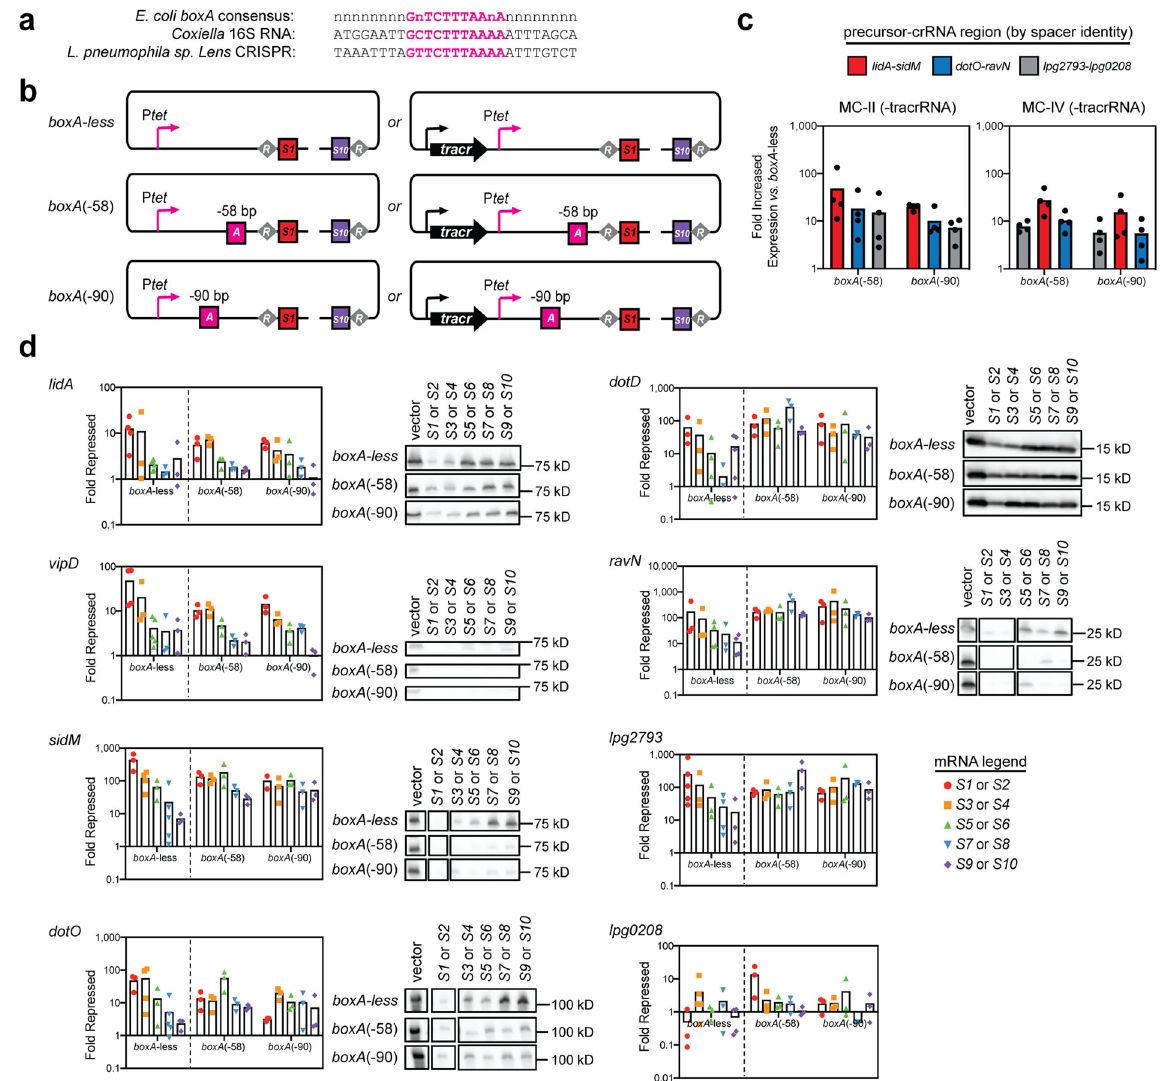
Fig. 4 The effect of boxA elements on gene silencing by P tet - MC arrays. a Sequence alignment of the boxA elements identi fi ed in E. coli (boxA consensus), Coxiella (16 S RNA encoding sequence), and L. pneumophila sp. Lens (CRISPR array). b The boxA motif from the L. pneumophila sp. Lens CRISPR array was added to the leader sequence of the P tet - MC constructs either -58 ( boxA (-58)) or -90 ( boxA (-90)) base pairs upstream of the repeat/spacer array. boxA is depicted as a pink square. c Constructs lacking the tracrRNA-encoding sequence were used to probe precursor-crRNA expression from boxA - containing vs. boxA -less constructs in axenic cultures of Lp02( dcas9 ) ( + 40 ng/mL aTC). Precursor-crRNA levels were measured by qPCR using primer pairs that annealed to three different regions of the precursor-crRNA. Fold increased expression vs. boxA -less constructs was determined using ΔΔ C T . Data are ordered by spacer position in constructs MC-II or MC-IV. d Constructs with the tracrRNA-encoding sequence were used to probe gene repression by qPCR of RNA from axenic cultures of Lp02( dcas9 ) bearing boxA constructs to that with the empty vector ( + 40 ng/mL aTC). Fold repression was determined using ΔΔ C T . For comparison, boxA -less qPCR data from Fig. 3 is shown again. For visualization of protein levels, pellets from boxA -less and boxA (-58) and boxA (-90) strains were collected and processed for immunoblot analysis. The bands were reordered corresponding to their spacer position. Original immunoblots and ICDH loading controls are shown in Supplementary Fig.